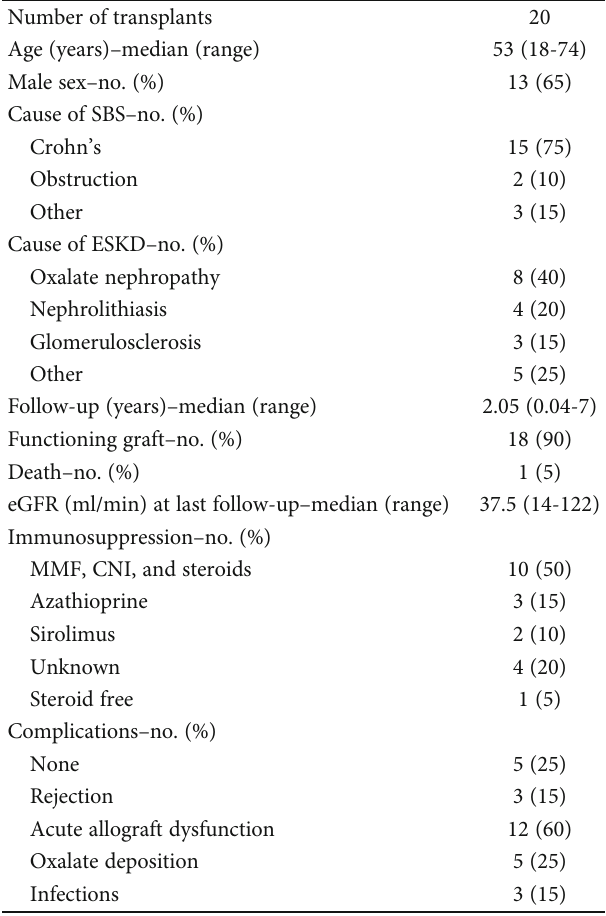
Table 1: Demographics, survival, and graft function in kidney transplant recipients with short bowel syndrome (including the current